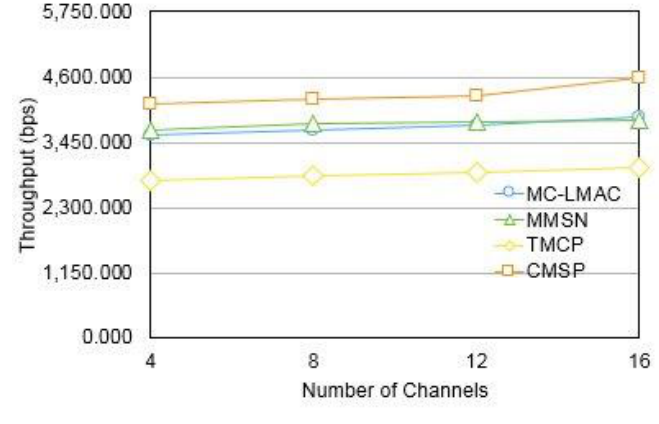
Figure 7. Throughput vs. number of channels.